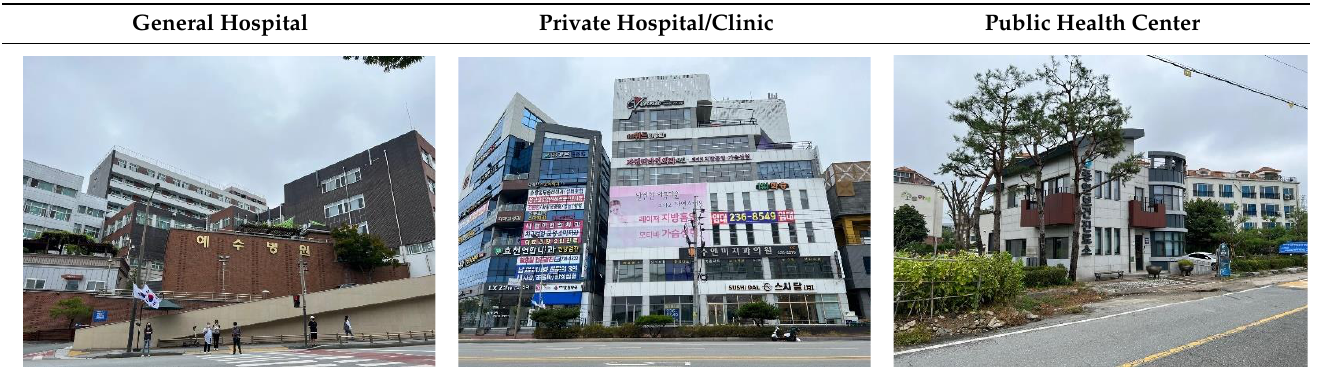
Table 1. Examples of the Three Types of Healthcare Services Explored in this Study (Photo by Sangwan Lee).